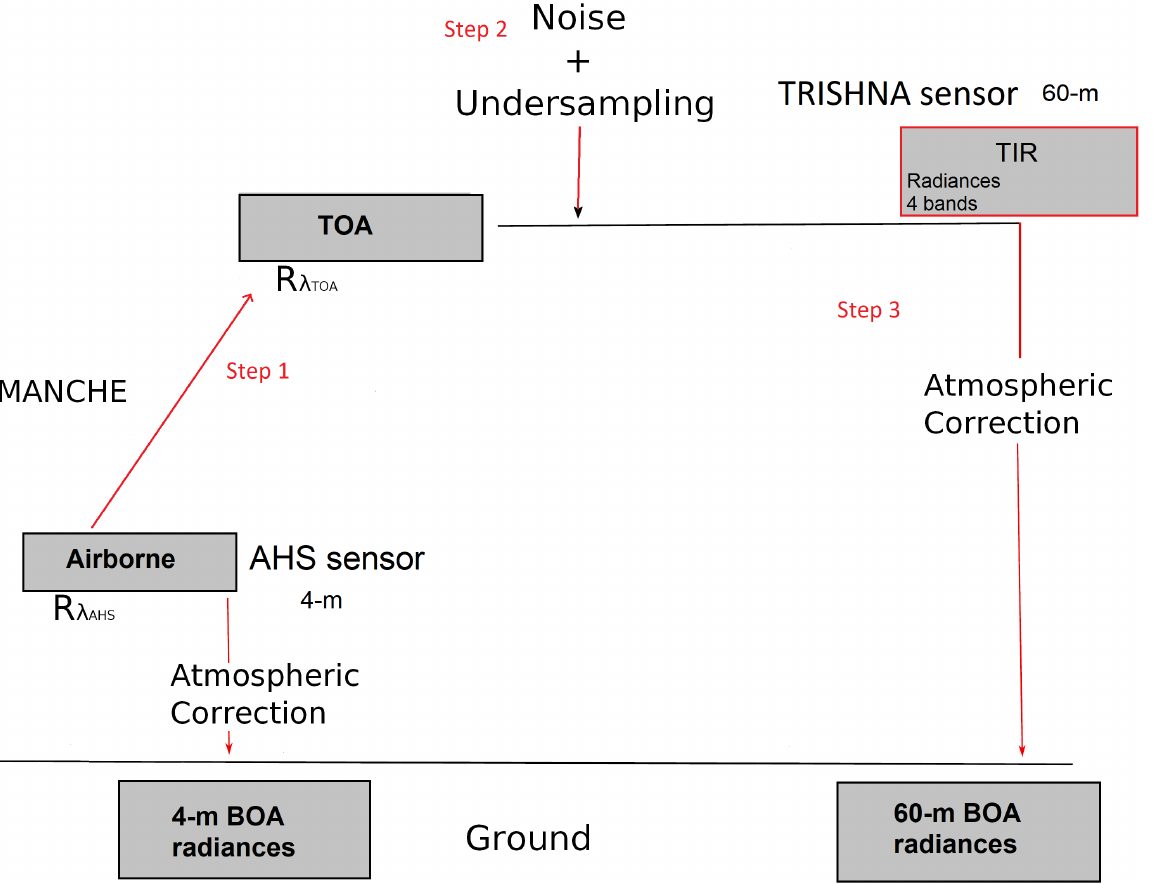
Figure 4. Processing scheme from AHS data to TRISHNA data in the